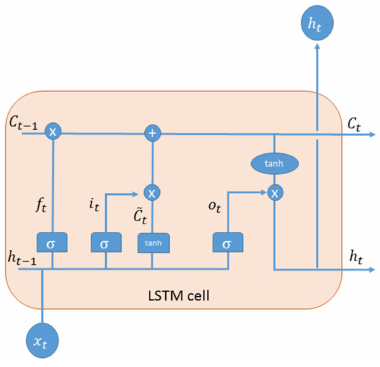
Figure 5. Classical LSTM cell